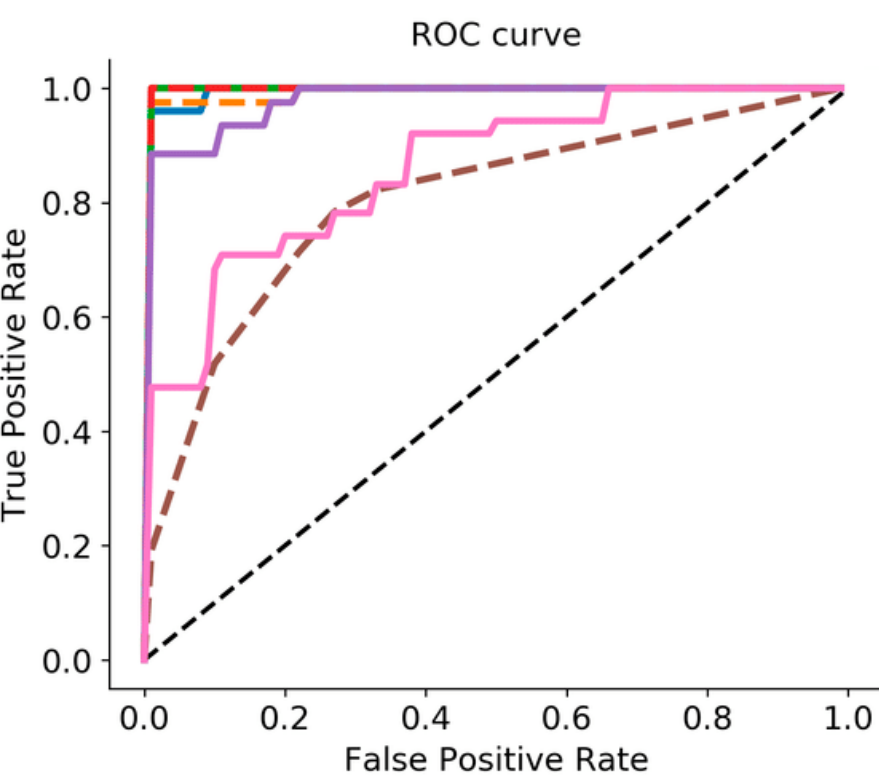
Figure 8. AUC curve for the Dns ‐ Net model, the greater the area under the curve the better accuracy.